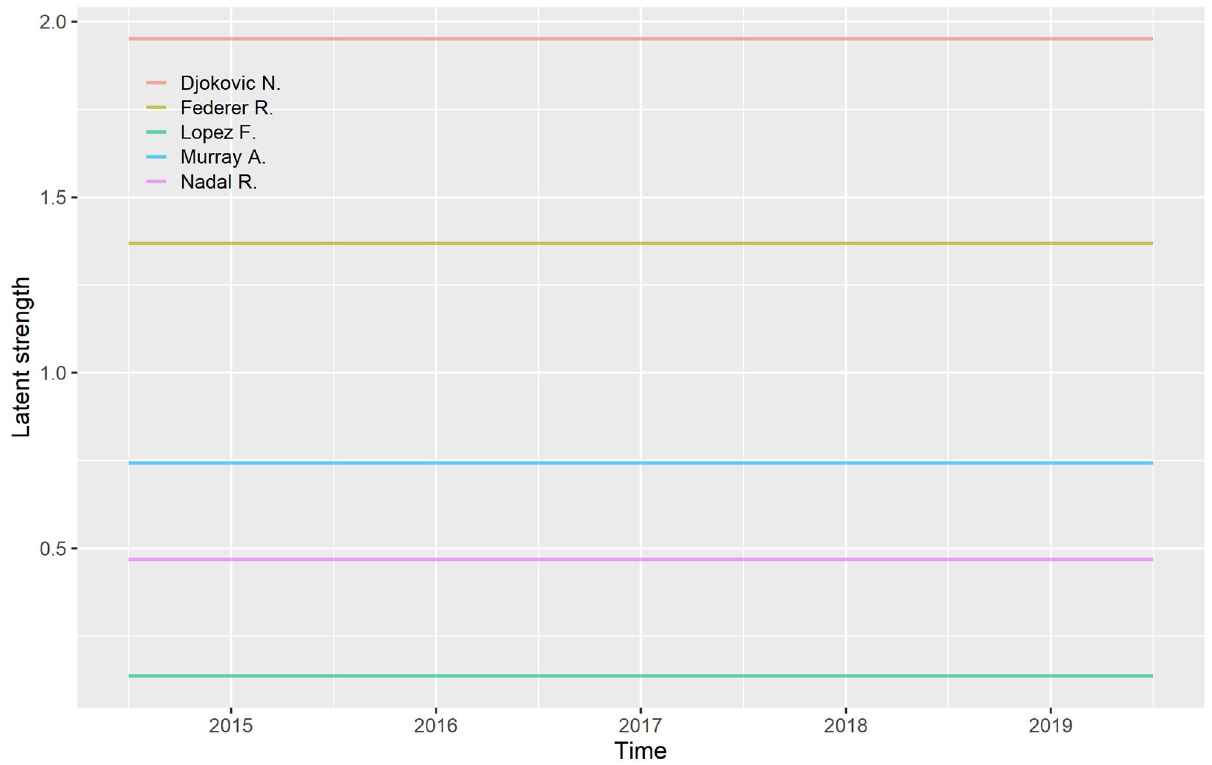
Fig 3. The five players with the highest latent strength according to the BASE model.